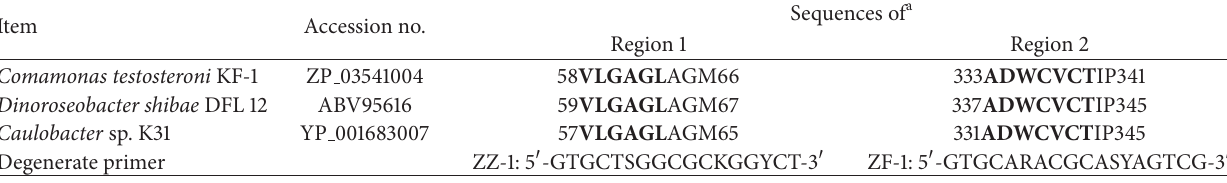
Table 1: Conserved regions of LAAOs from common marine microorganisms used for design of degenerate primers. Item Accession no.